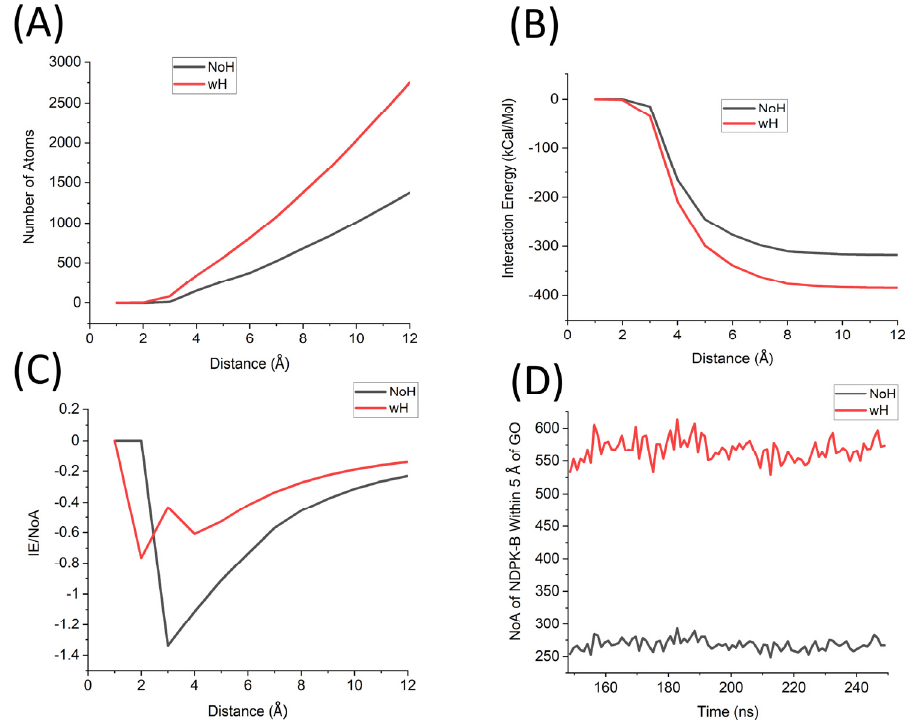
Figure 6. Optimal distance analysis between NDPK-B and GO: ( A ) Number of atoms between NDPK-B and GO as a function of distance with and without hydrogen atoms; ( B ) Total interaction energy between NDPK-B and GO as a function of distance with and without hydrogen atoms; ( C ) Maximum interaction energy per atom between NDPK-B and GO as a function of distance with and without hydrogen atoms; ( D ) Number of atoms (NoA) of NDPK-B within 5 Å of GO as a function of time with and without hydrogen atoms.